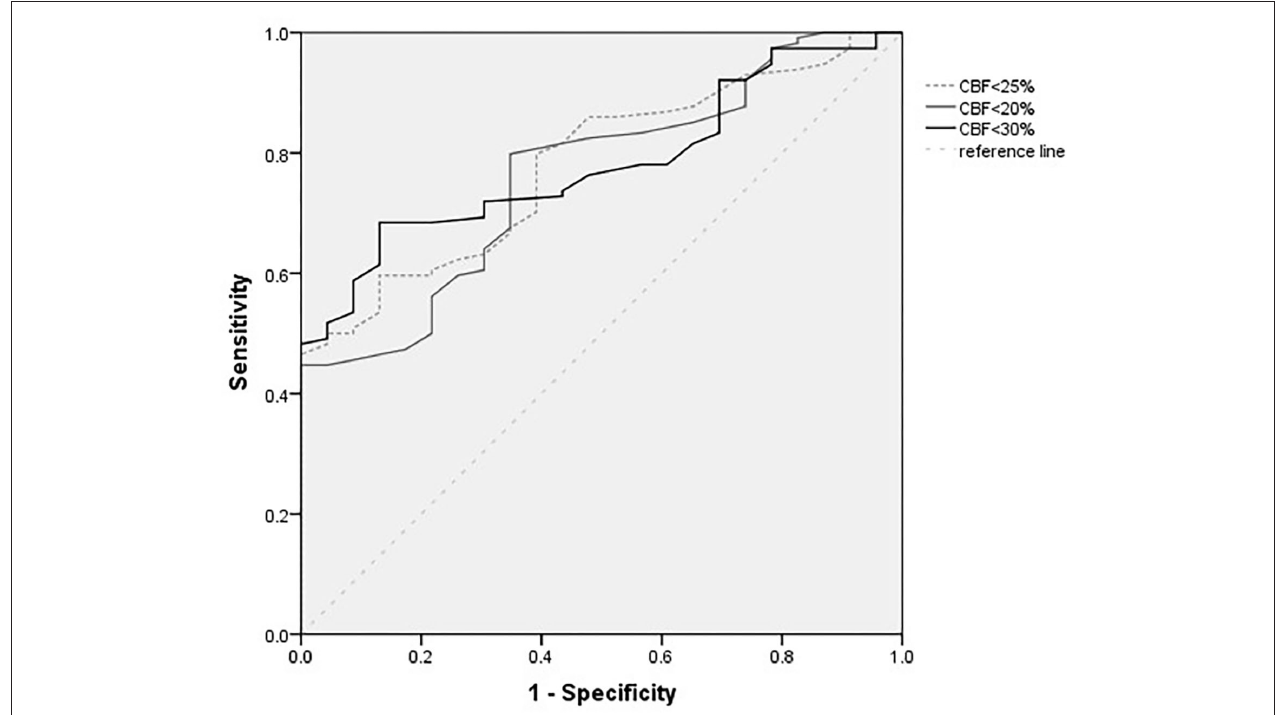
FIGURE 2 | Receiver operating characteristic curves for age (year) and ischemic core volumes of patients with baseline core volumes larger than 70ml.